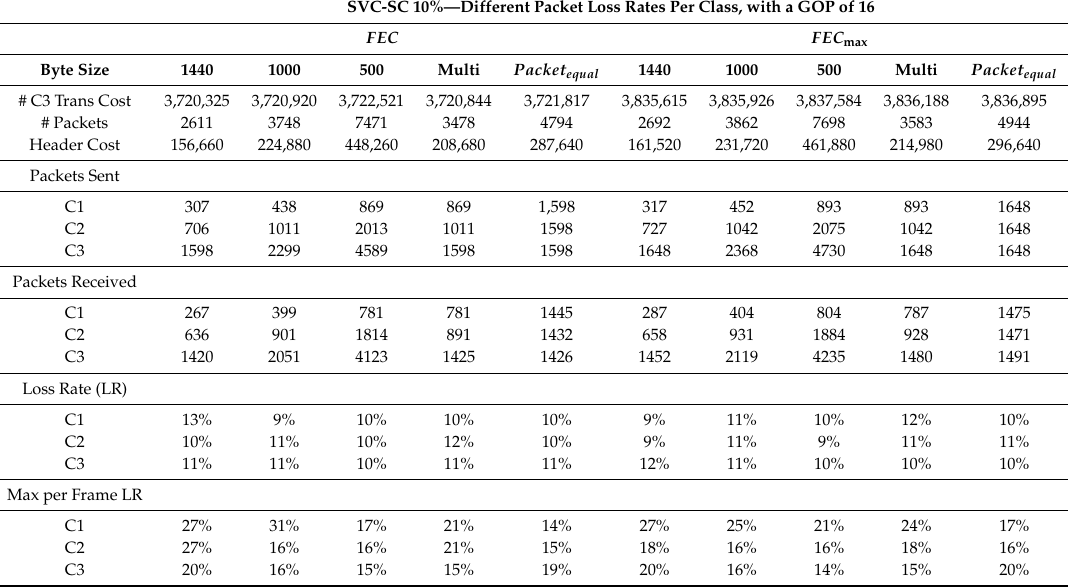
Table A7. FEC and FEC max models for all four Packet thres , as well as Packet equal . Values are illustrated for packets transmitted, additional packet header cost (60 bytes per packet) and individual packets sent, packets received, loss rate per class and maximum loss rate per frame for SVC-SC, for an overall packet loss rate of 10% and a GOP of